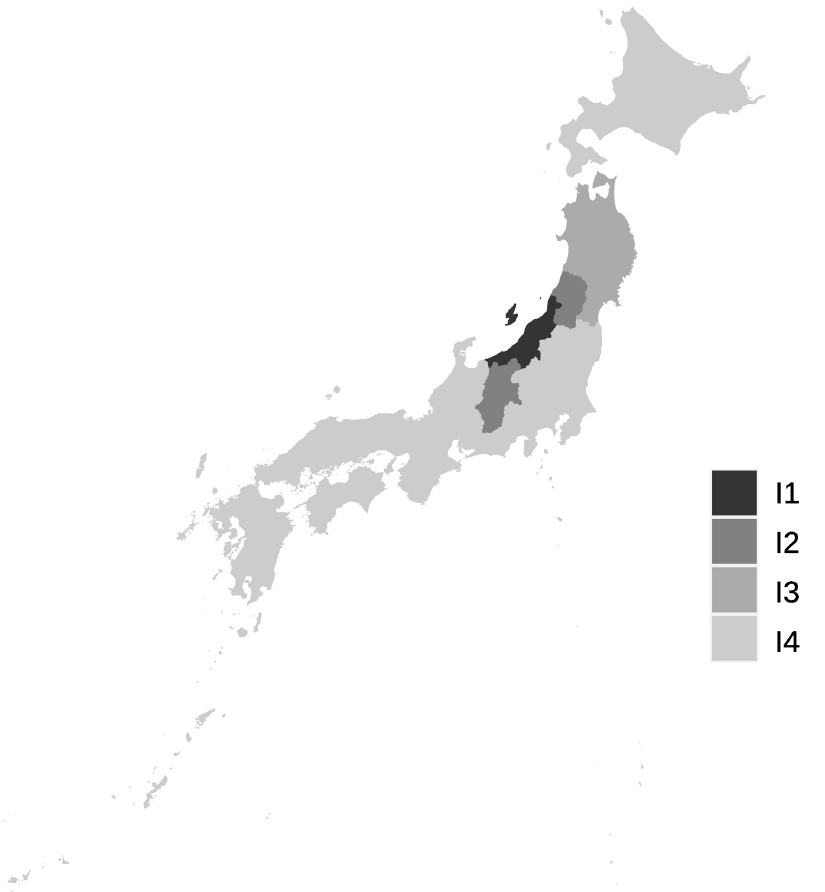
Fig 14. Prefectures belonging to clusters for inbound